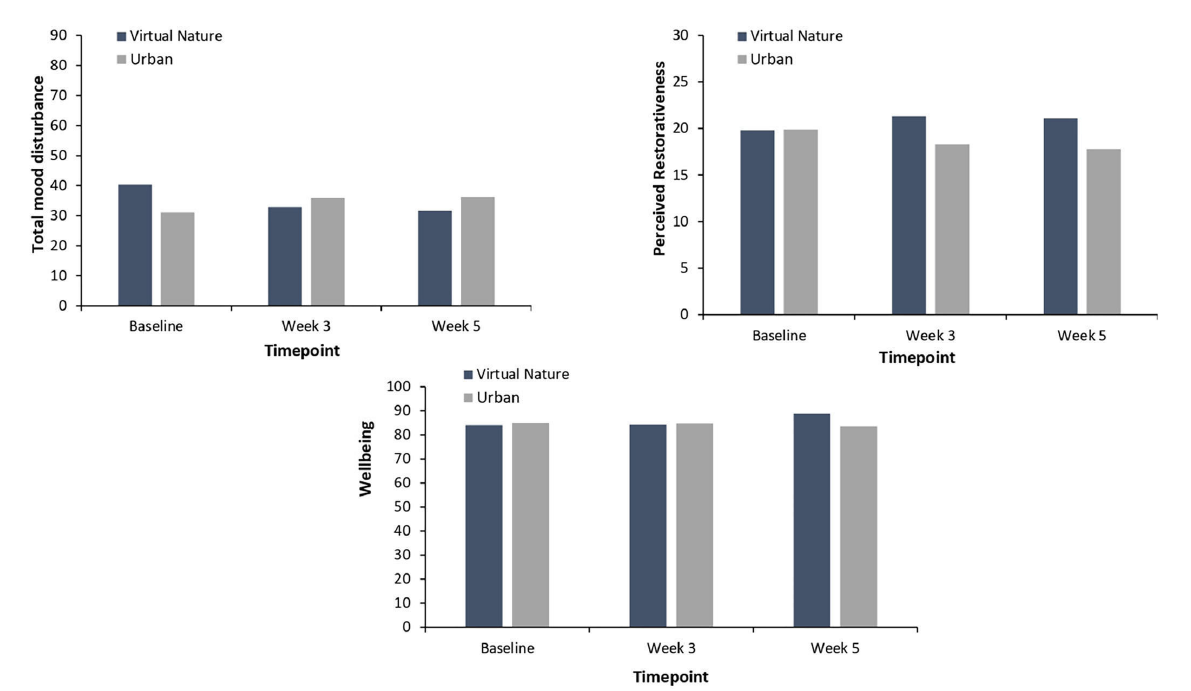
FIGURE5 Levels of perceived restorativeness, total mood disturbance, and psychological wellbeing of the virtual nature group and urban group at baseline, week 3 and week 5. No significant difference was found between the groups in week 3 and the week 5. Moreover, no significant changes were found in either group between baseline and week